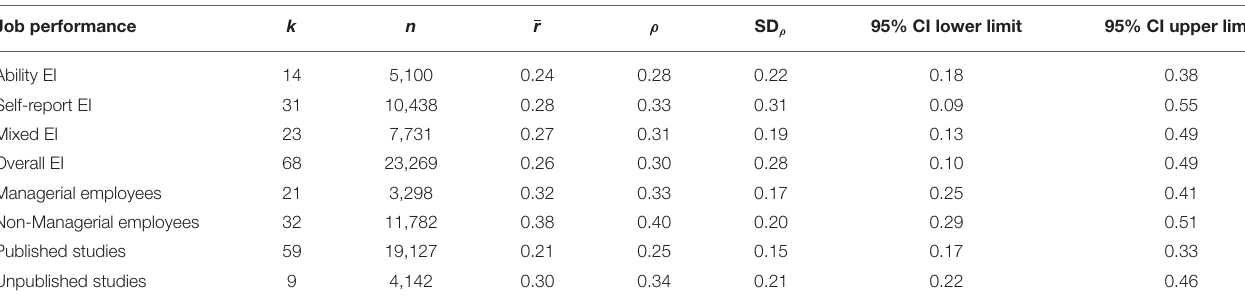
TABLE 6 | Meta-analytic results of the relationship between EI and job